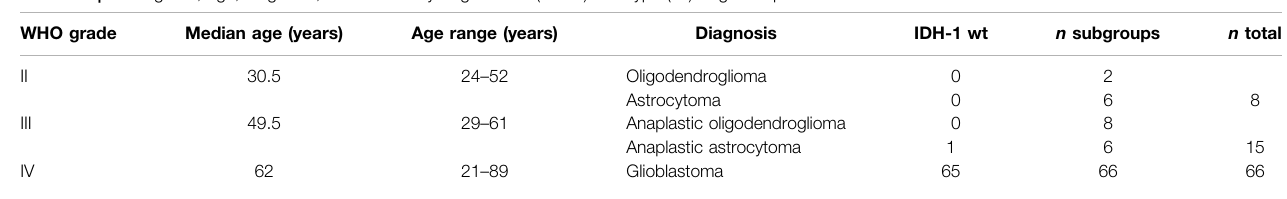
TABLE 1 | WHO grade, age, diagnosis, isocitrate-dehydrogenase 1 (IDH-1) wild type (wt) of glioma patients. WHO grade Median age